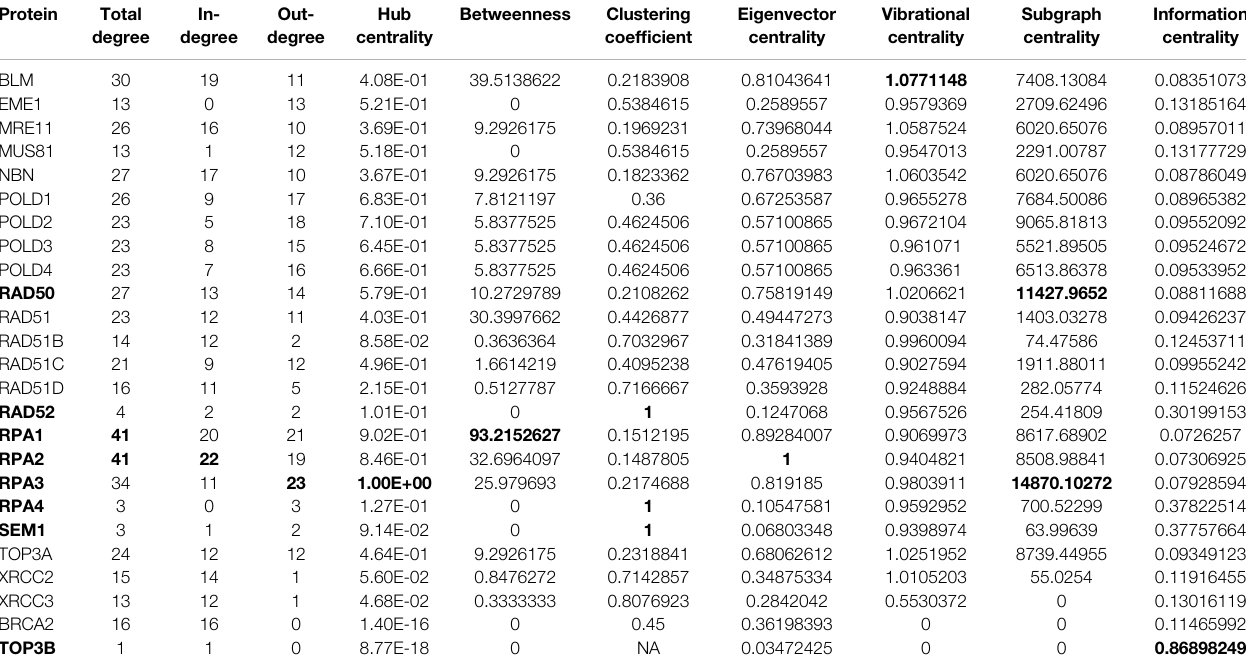
TABLE 4 | Values of the centrality measures for the HR pathway in (Orlic-Milacic, 2015). In bold, we marked the genes/proteins with the highest scores.